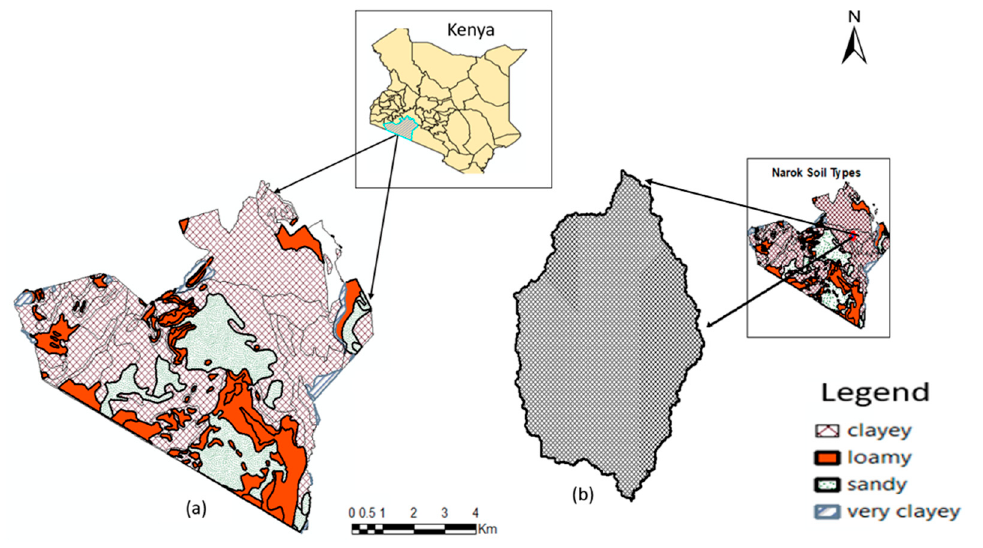
Figure 3. Soil type map of Narok County ( a ) and selected study area ( b